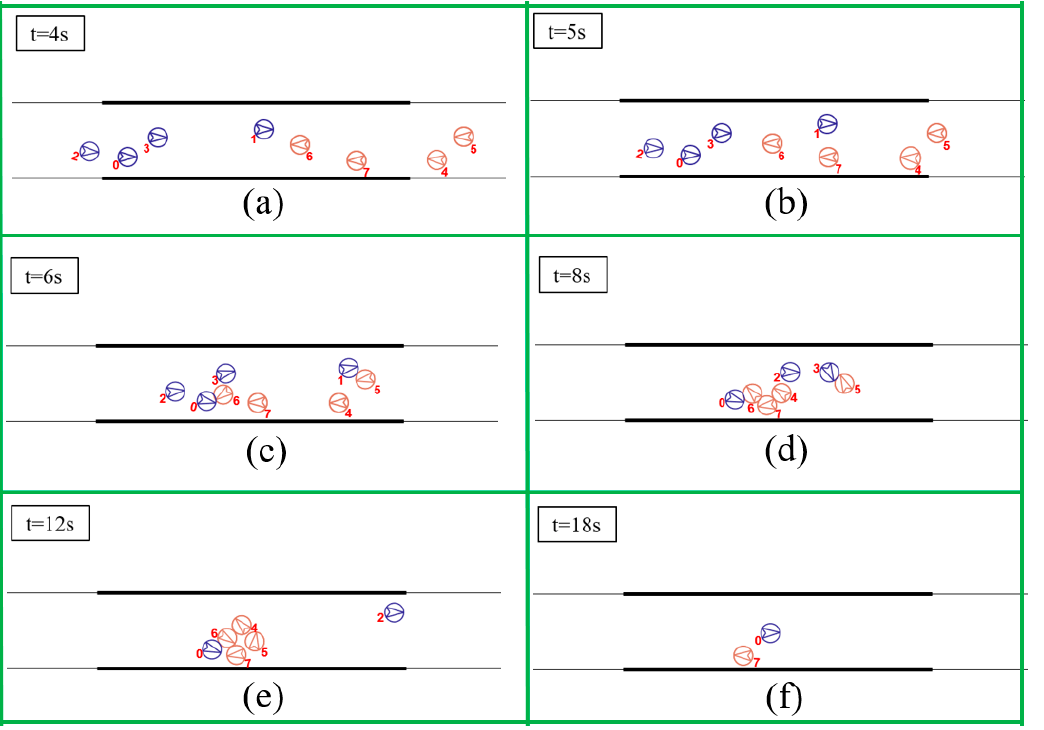
Figure 18. Screenshot of simulation of phase motion.